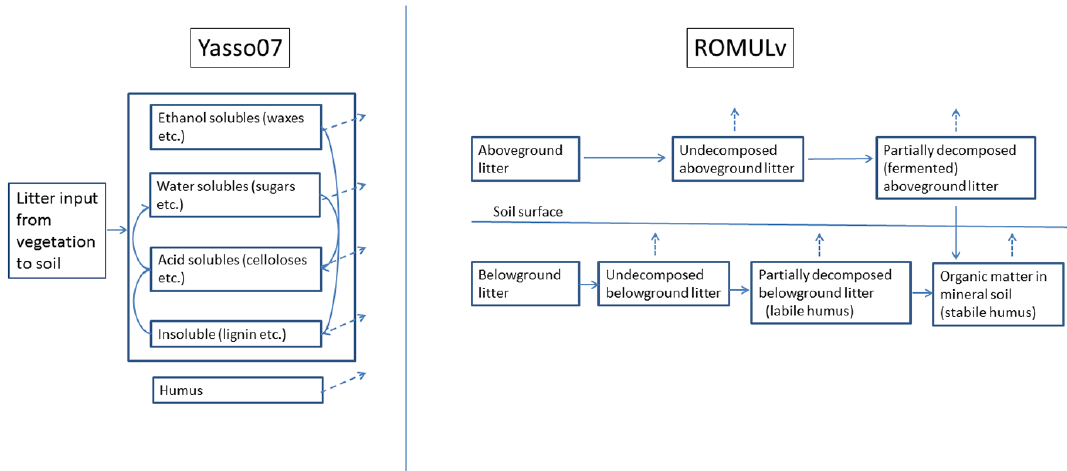
Figure 1. Schematic illustration of Yasso07 (left) and ROMULv (right) soil carbon models. Solid arrows indicate fluxes of organic matter, while dashed arrows indicate CO 2 fluxes to